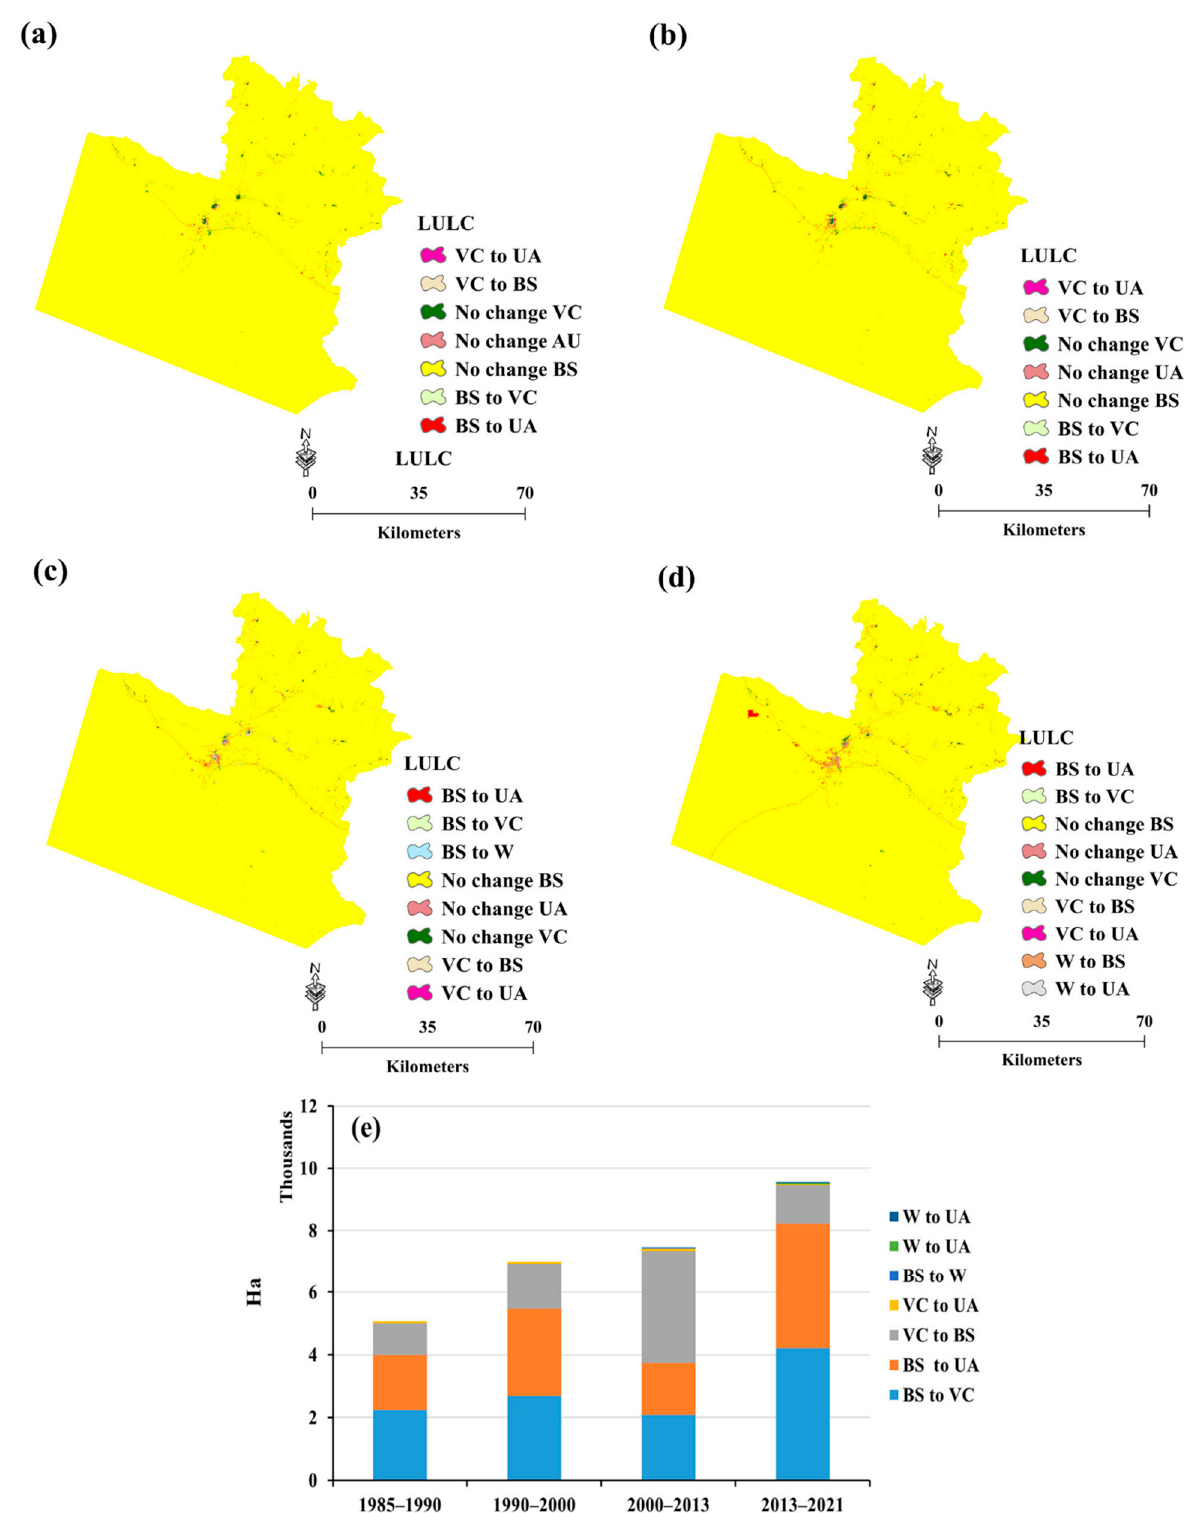
Figure 7. LULC in Ibri ( a ) 1985–1990, ( b ) 1990–2000, ( c ) 2000–2013, ( d ) 2013–2021 and ( e ) the overall LULC changes for 1985–2021 (BS = Bare Soil; VC = Vegetation Cover Soil; UA = Urban Area; W = Water).